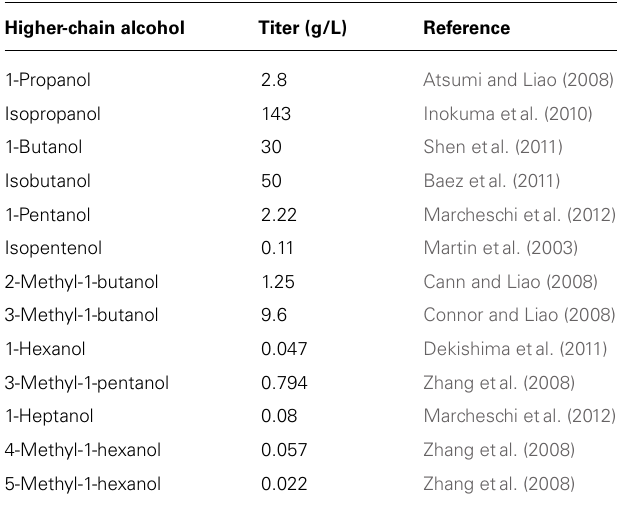
Table 1 | Highest reported higher-chain alcohol titers in E. coli